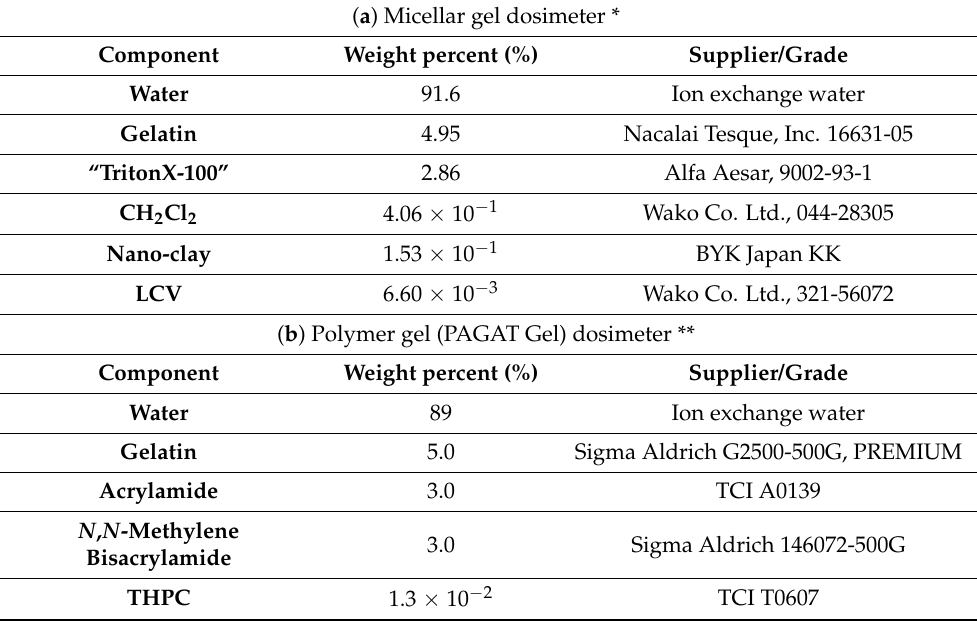
Table 1. Composition of the two gel dosimeters. ( a ) Micellar gel dosimeter * Component Weight percent (%)